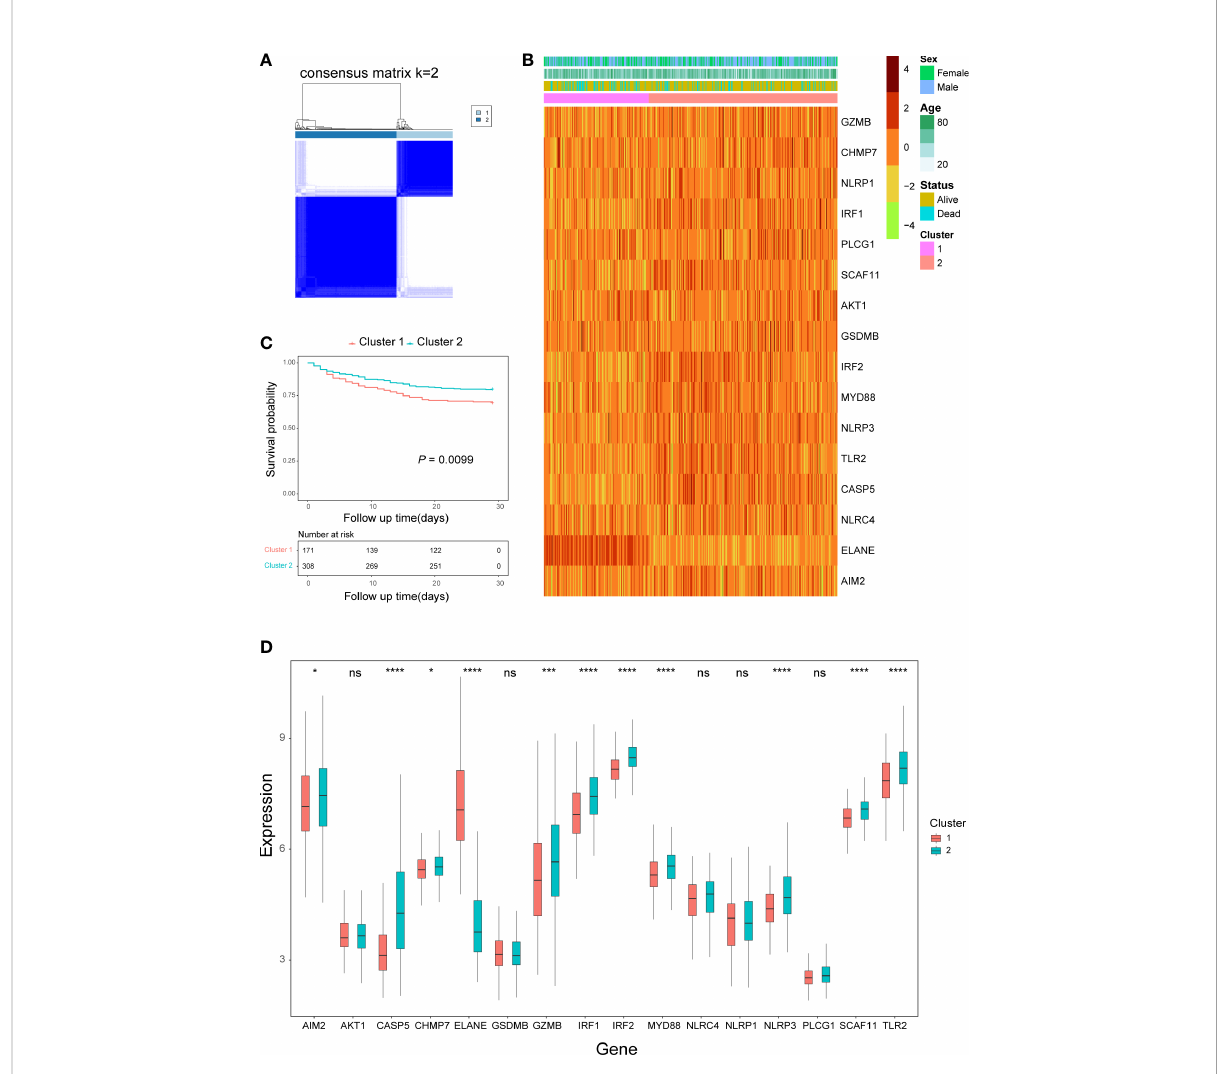
FIGURE 2 Consensus clustering analysis based on pyroptosis-related DEGs. (A) Consensus matrix when k=2. (B) Heatmap of pyroptosis-related DEGs expression and clinical characteristics in the two clusters. (C) Kaplan-Meier curves analysis for the survival of patients between the two clusters. (D) Box plots of pyroptosis-related DEGs expression level in the two clusters. ns, not signi fi cant; * P < 0.05,*** P < 0.001, **** P <